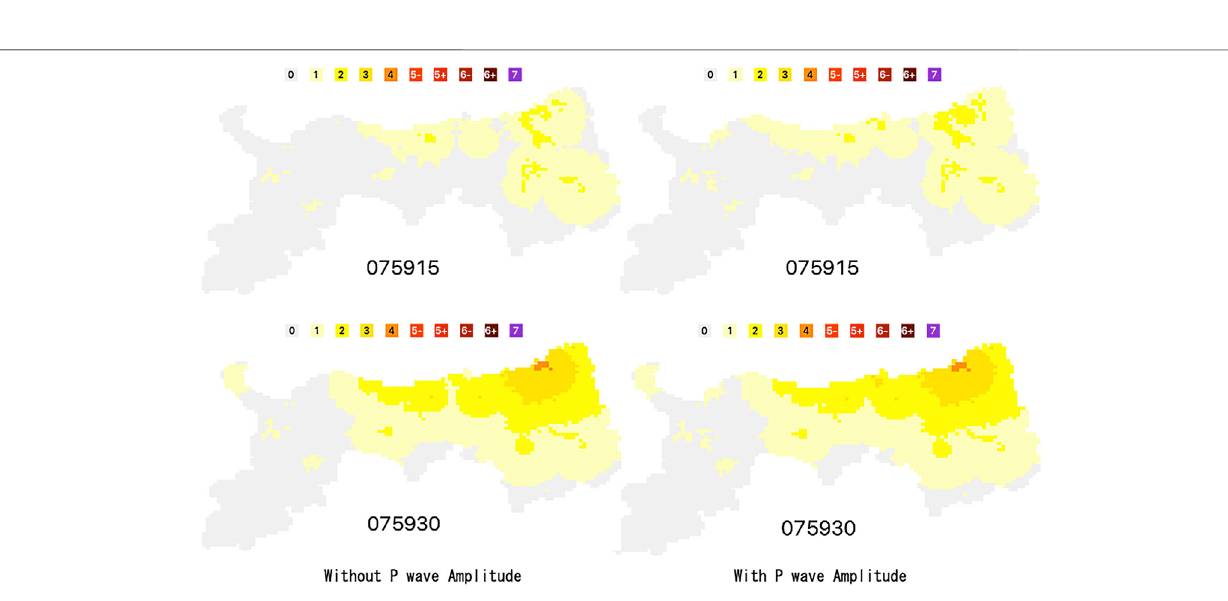
FIGURE 13 | Same as Figure 10 but for the 2018 Northern Osaka Prefecture Earthquake.